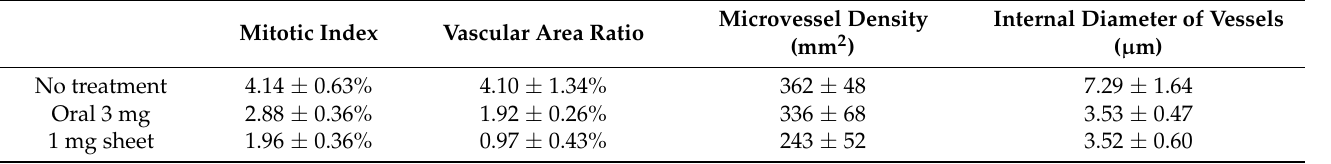
Table 3. Immunohistochemical data